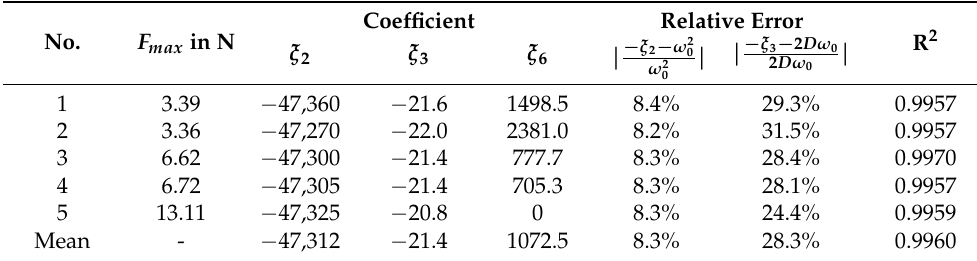
Table 4. Identified coefficients by using impulse excitation and their errors compared with the theoretical values from Table